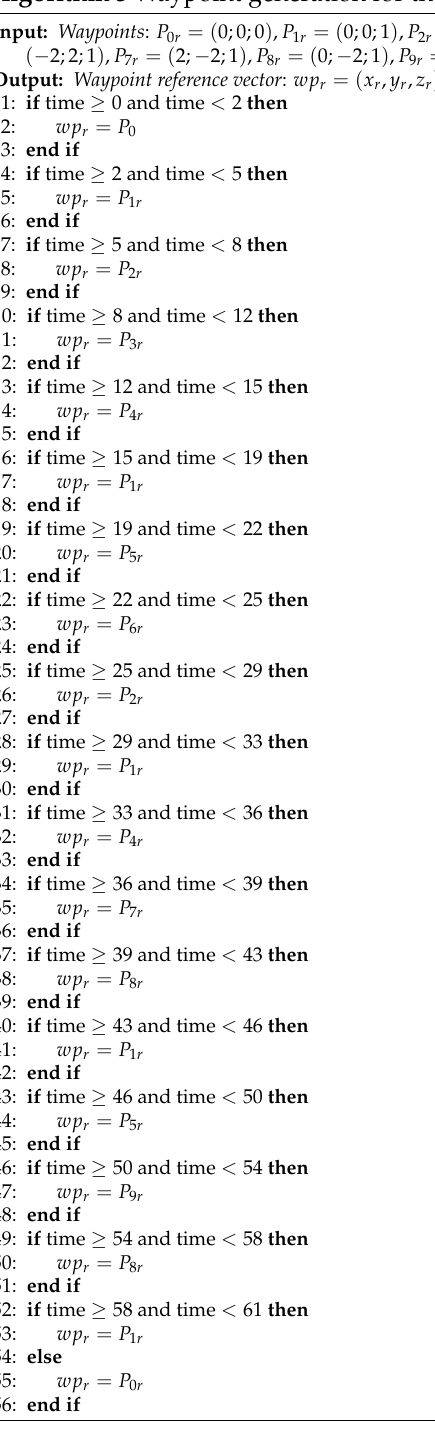
Algorithm 3 Waypoint generation for the 3rd